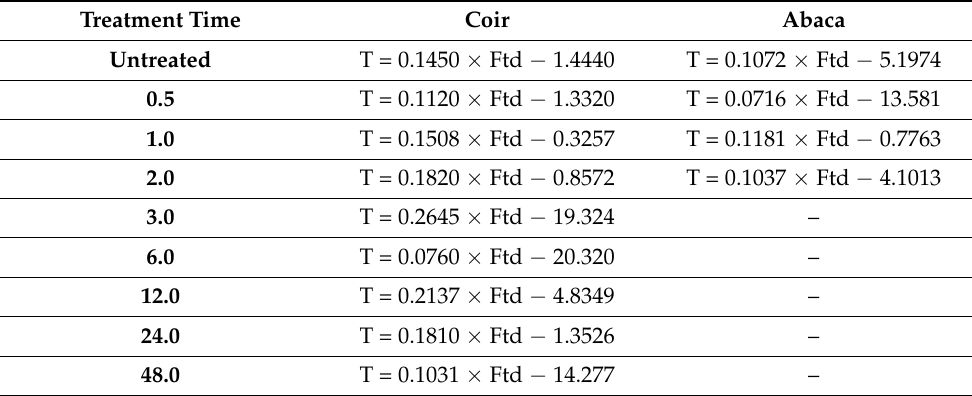
Table 3. Trend equations: Influence of the fiber transverse dimension on the calculated (assuming a circular cross-section) and measured linear density of the tested coir and abaca fibers (T-linear density, Ftd–fiber transverse dimension).